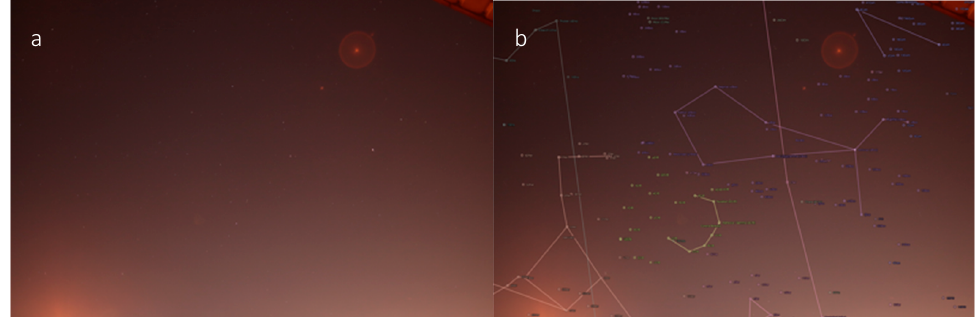
Figure 16. Astrometric calibration results: ( a ) input image, ( b ) recognized constellations.